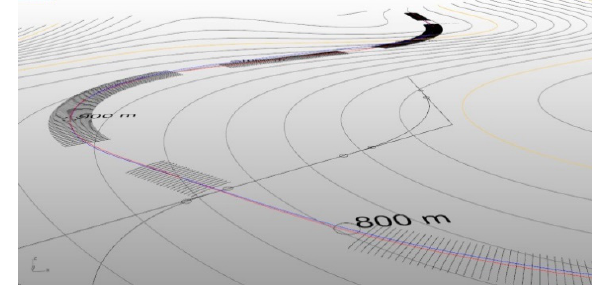
Figure 5. Creation of road track.